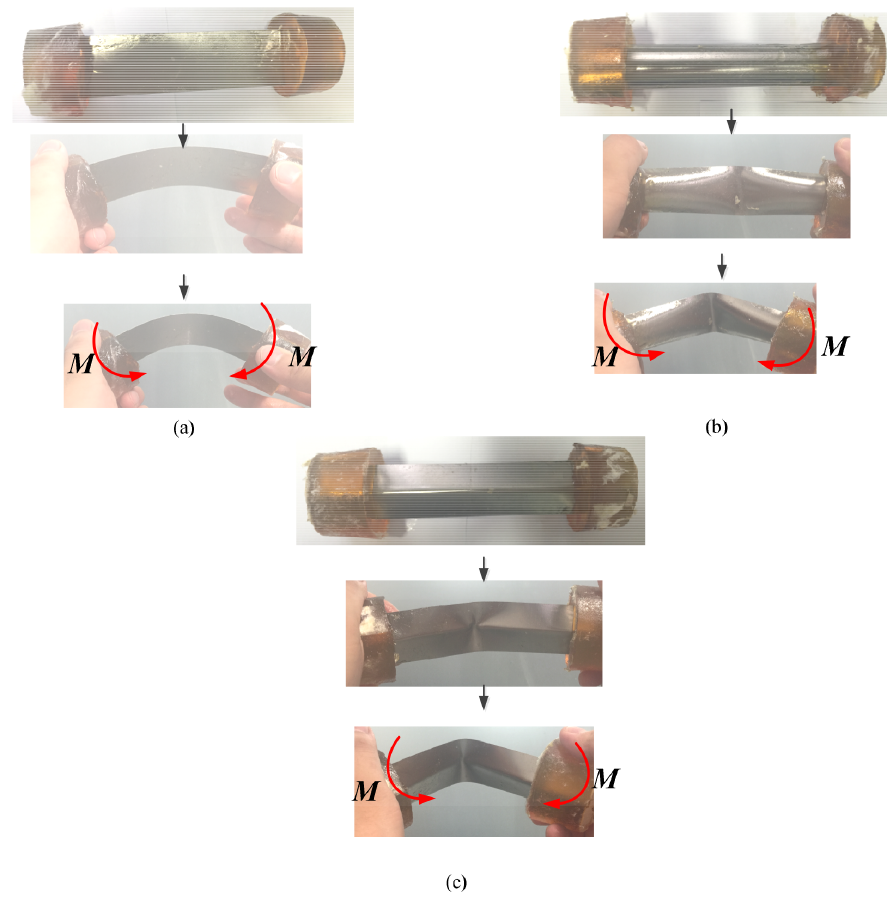
Figure 4. Folding processes of physical models for (a) flat strip, (b) curved strip, and (c) creased strip.